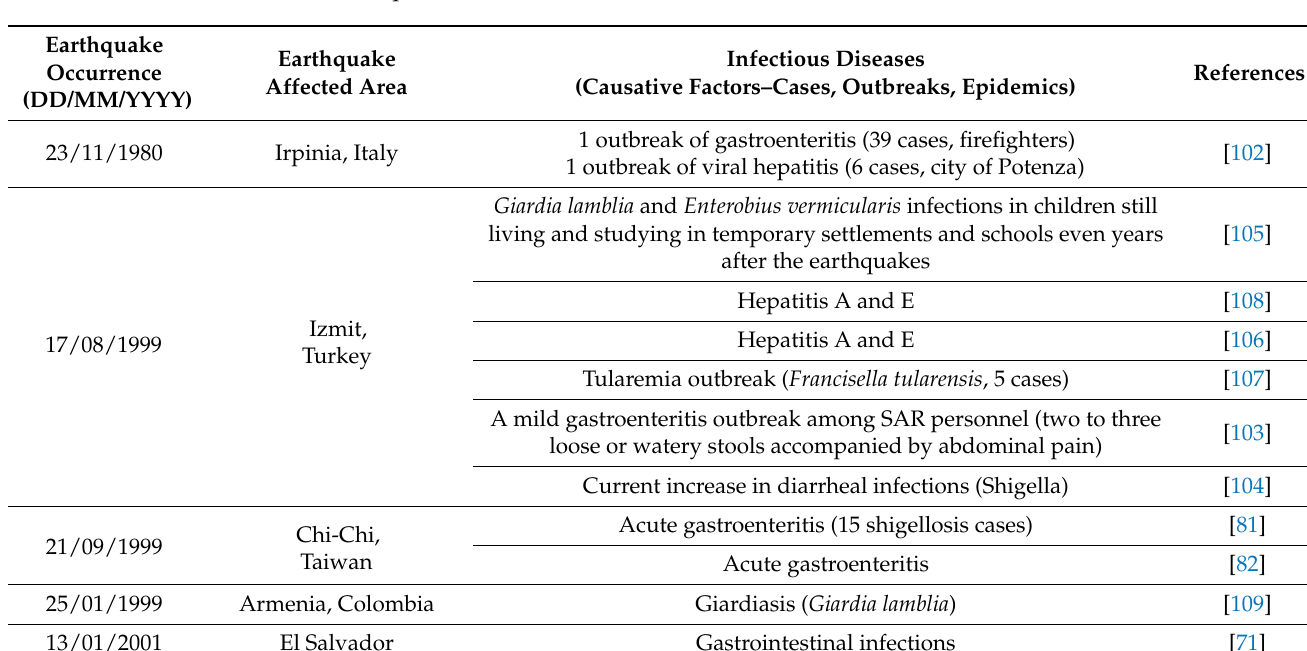
Table 3. Water- and food-borne infectious diseases transmitted during the post-earthquake period in earthquake-affected